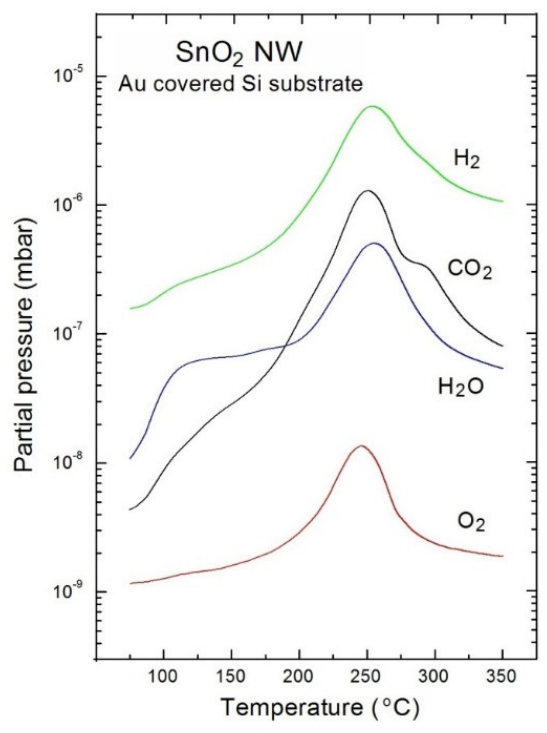
Figure 5. TDS spectra of the main residual gases desorbed from the VPD SnO 2 nanowires deposited on an Au-covered Si substrate